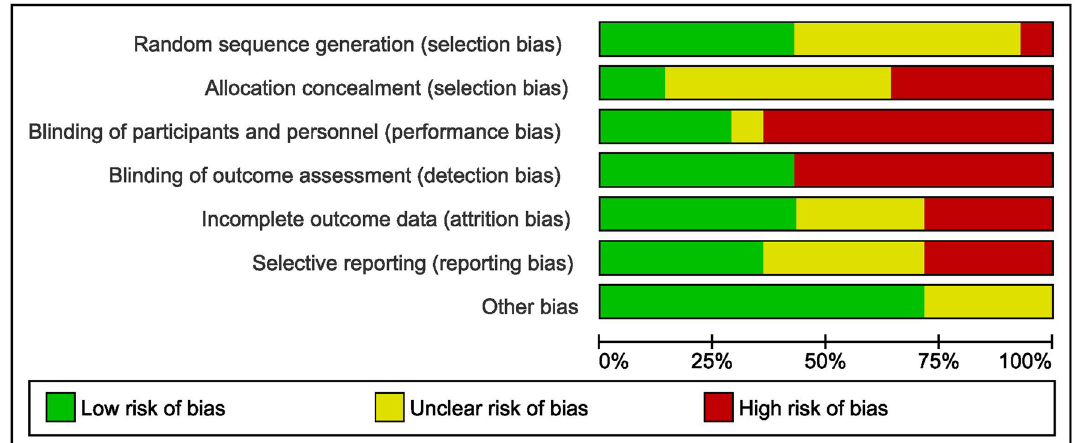
Figure 3. Risk of bias graph: review authors’ judgements about each risk of bias item presented as percentages across all included studies.